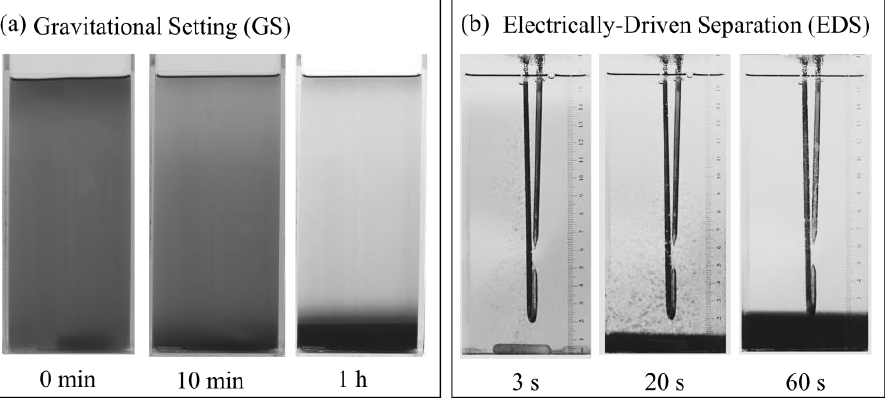
Figure 14. Observation on the formation of a clear interface between biodiesel and glycerol by-product over the separation time using two separation processes: ( a ) gravitational settling (GS) and ( b ) electrically driven separation (EDS).